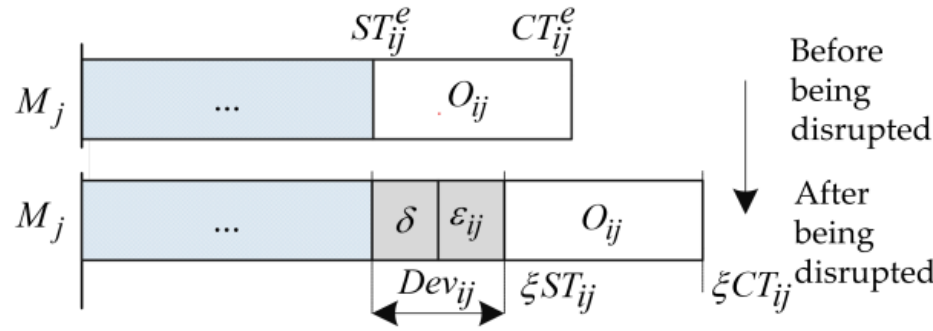
Figure 1. The start time deviation after being disrupted.